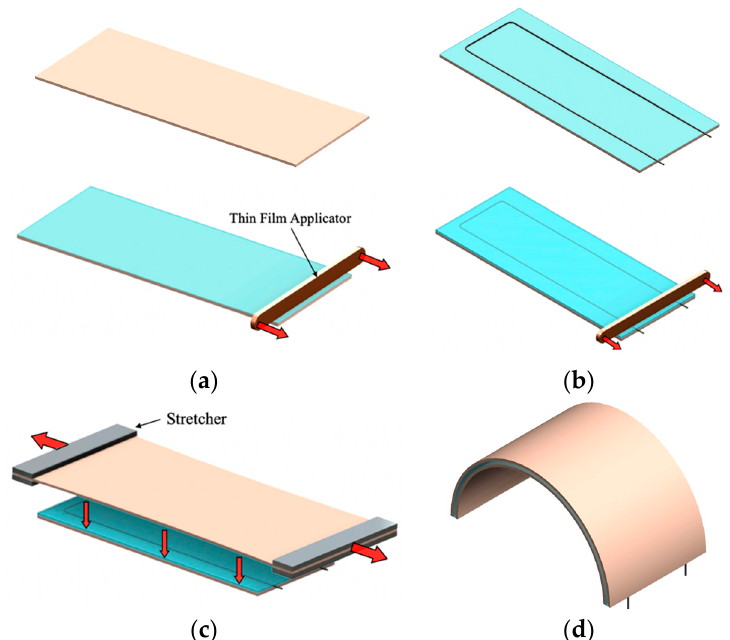
Figure 1. Construction process for each actuator. ( a ) Apply a 0.2 mm thick layer of silicone (Ecoflex 30) on top of the 55 × 22 × 0.5 mm thermally conductive elastic tape using a thin film applicator; ( b ) Place the SMA wire in a U-shape on the half-cured silicone and apply a 0.4 mm thick layer of silicone (Ecoflex 30) on top; ( c ) Prestretch the 70 × 37 × 0.5 mm thermally conductive elastic tape and bond it on top of the rest of the layers; ( d ) When the silicone (Ecoflex 30) is fully cured, cut out the actuator.